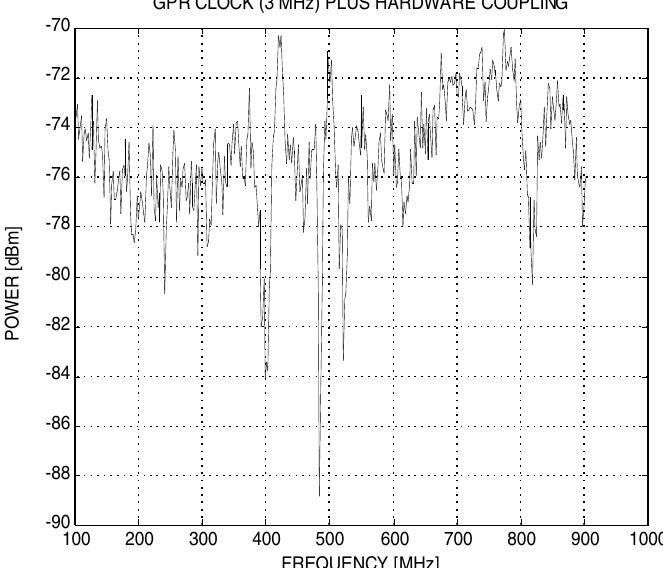
Fig. 9. Result of an averaging performed on the sum of the electromagnetic coupling and the noise generated by the timing